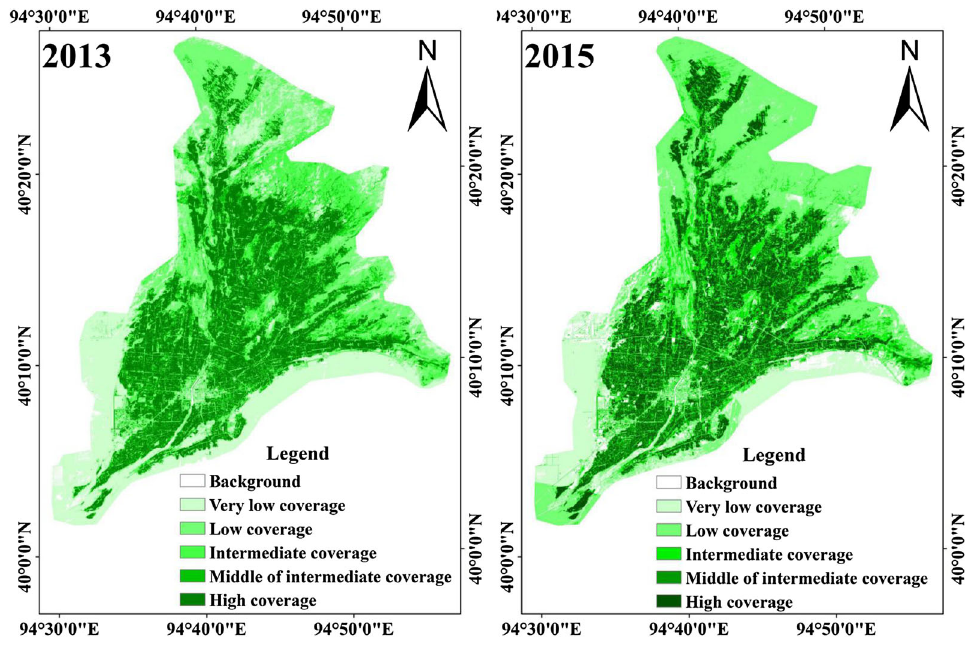
Fig. 3 The FVC classification figures (Left: 2013a, Right: 2015a)